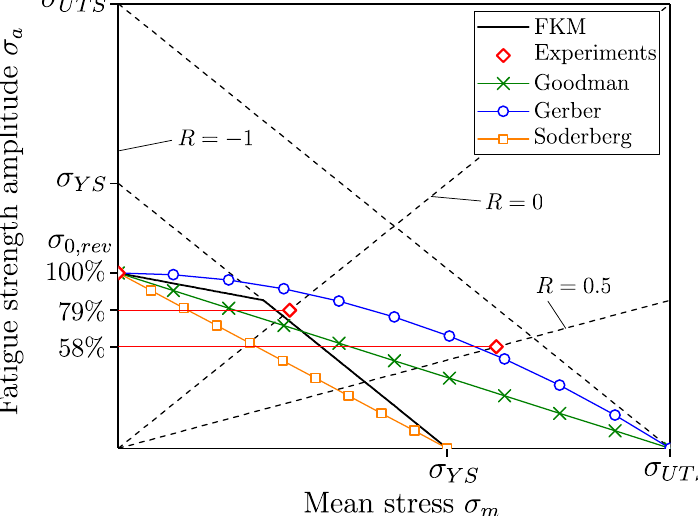
Figure 9. Haigh diagram depicting the experimental